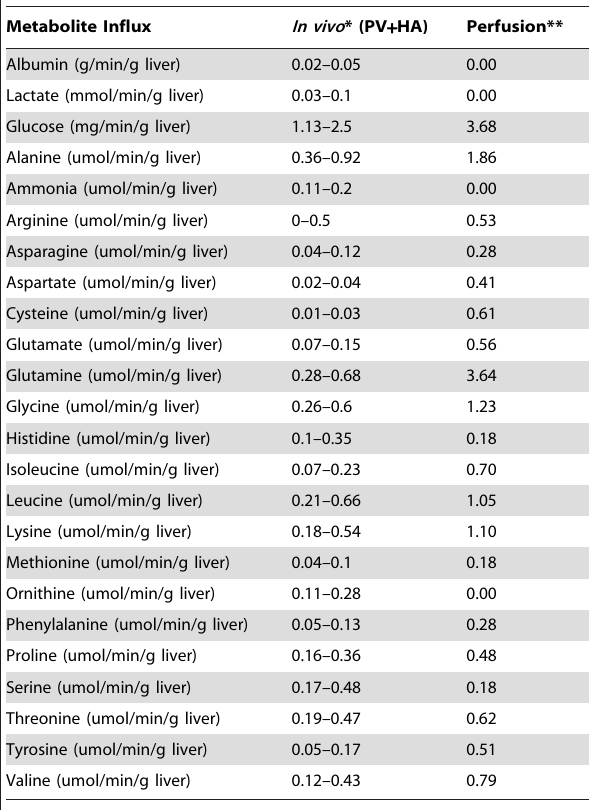
Table 1. Measured Influx